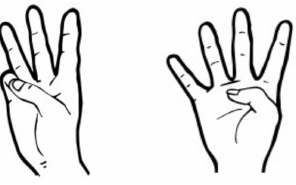
Figure 3. The difference between the letter W and the digit 4 would disappear in a three-fingered